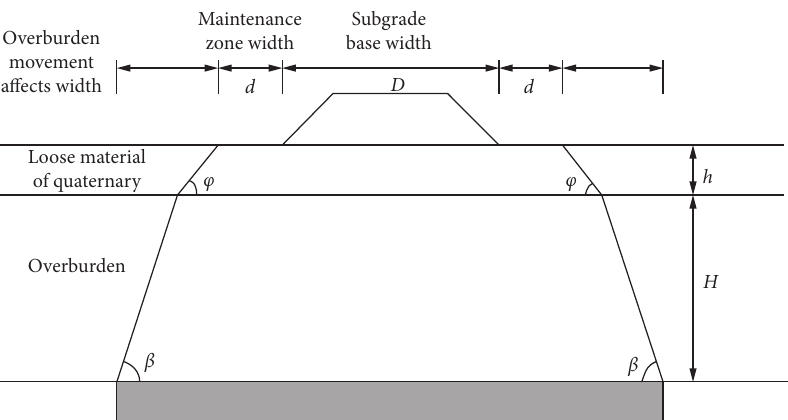
Figure 16: Treatment width of goaf.